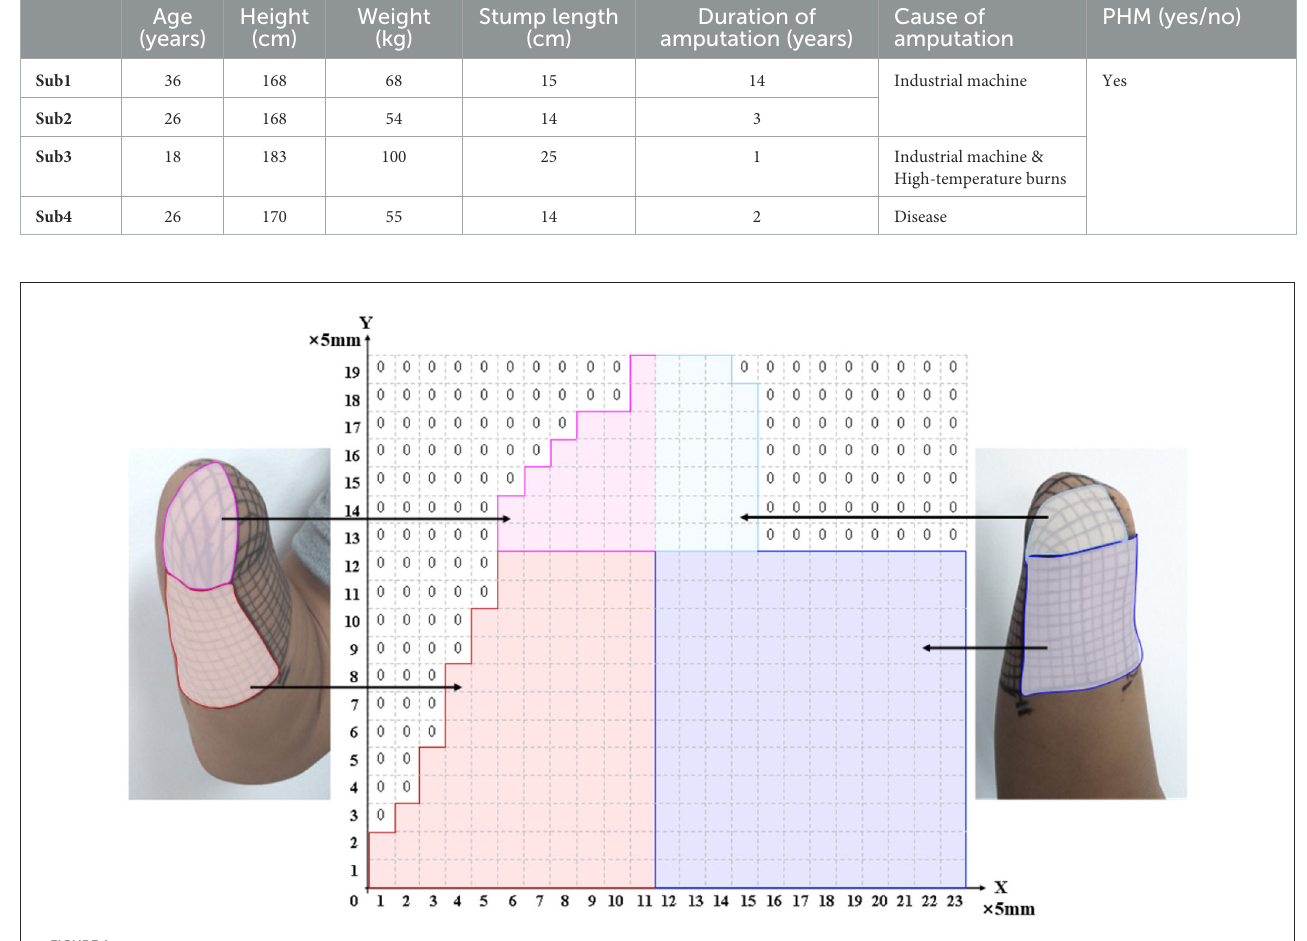
at each determined stimulus position under each selected set of stimulus parameters, were counted, and their respective frequencies in all experiments were calculated. For instance, the frequency of each phantom finger position evoked at one stimulus location was calculated as the ratio of the number of times that the finger position appeared at that stimulus position to the total number of all possible finger positions evoked at that stimulus position in all experiments. This calculation method for the frequency of positions was also used for the frequency of sensation types. In the end, the stable relationships among stimulation positions, parameters, different levels of intensity, and evoked sensations were confirmed, and the stimulus parameters with the best effectiveness in phantom finger sensation induction were